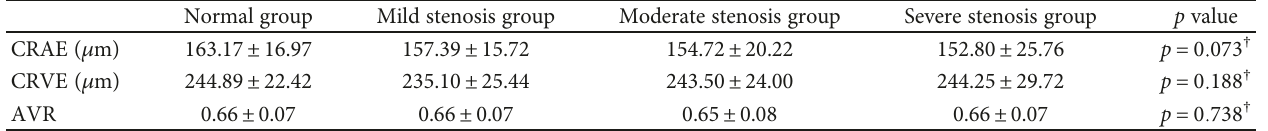
Table 2: Retinal vascular diameter and arteriolar-to-venular diameter ratio (AVR).